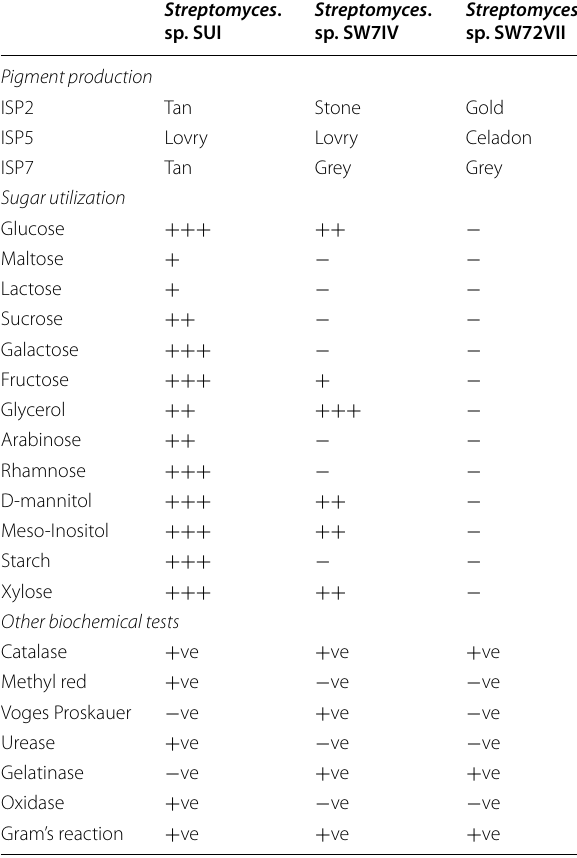
Table 2 Pigment production, sugar utilization and biochemical characteristics of Streptomyces sp. SUI, Streptomyces sp. SW72IV and Streptomyces sp.